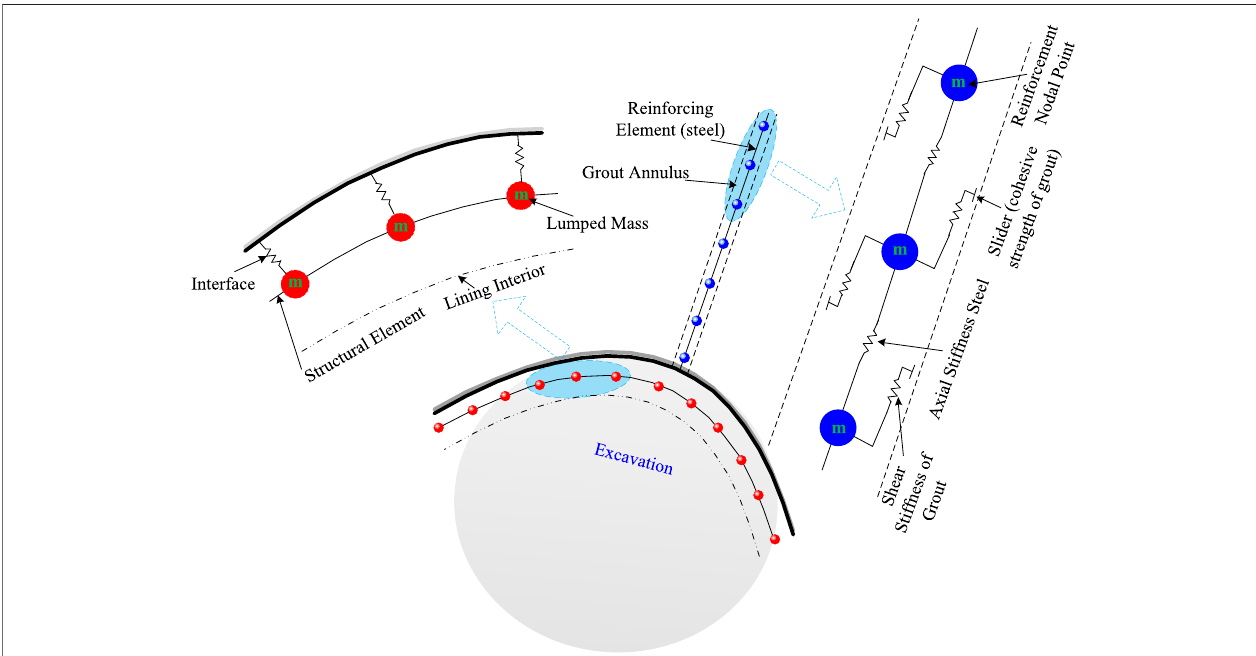
FIGURE7| SchematicdiagramoftherealizationofUDECstructuralcomponentsofanchoringrockbolts,anchorcables,andreinforcingladderbeams(Inc.,2014; Qian et al., 2016).